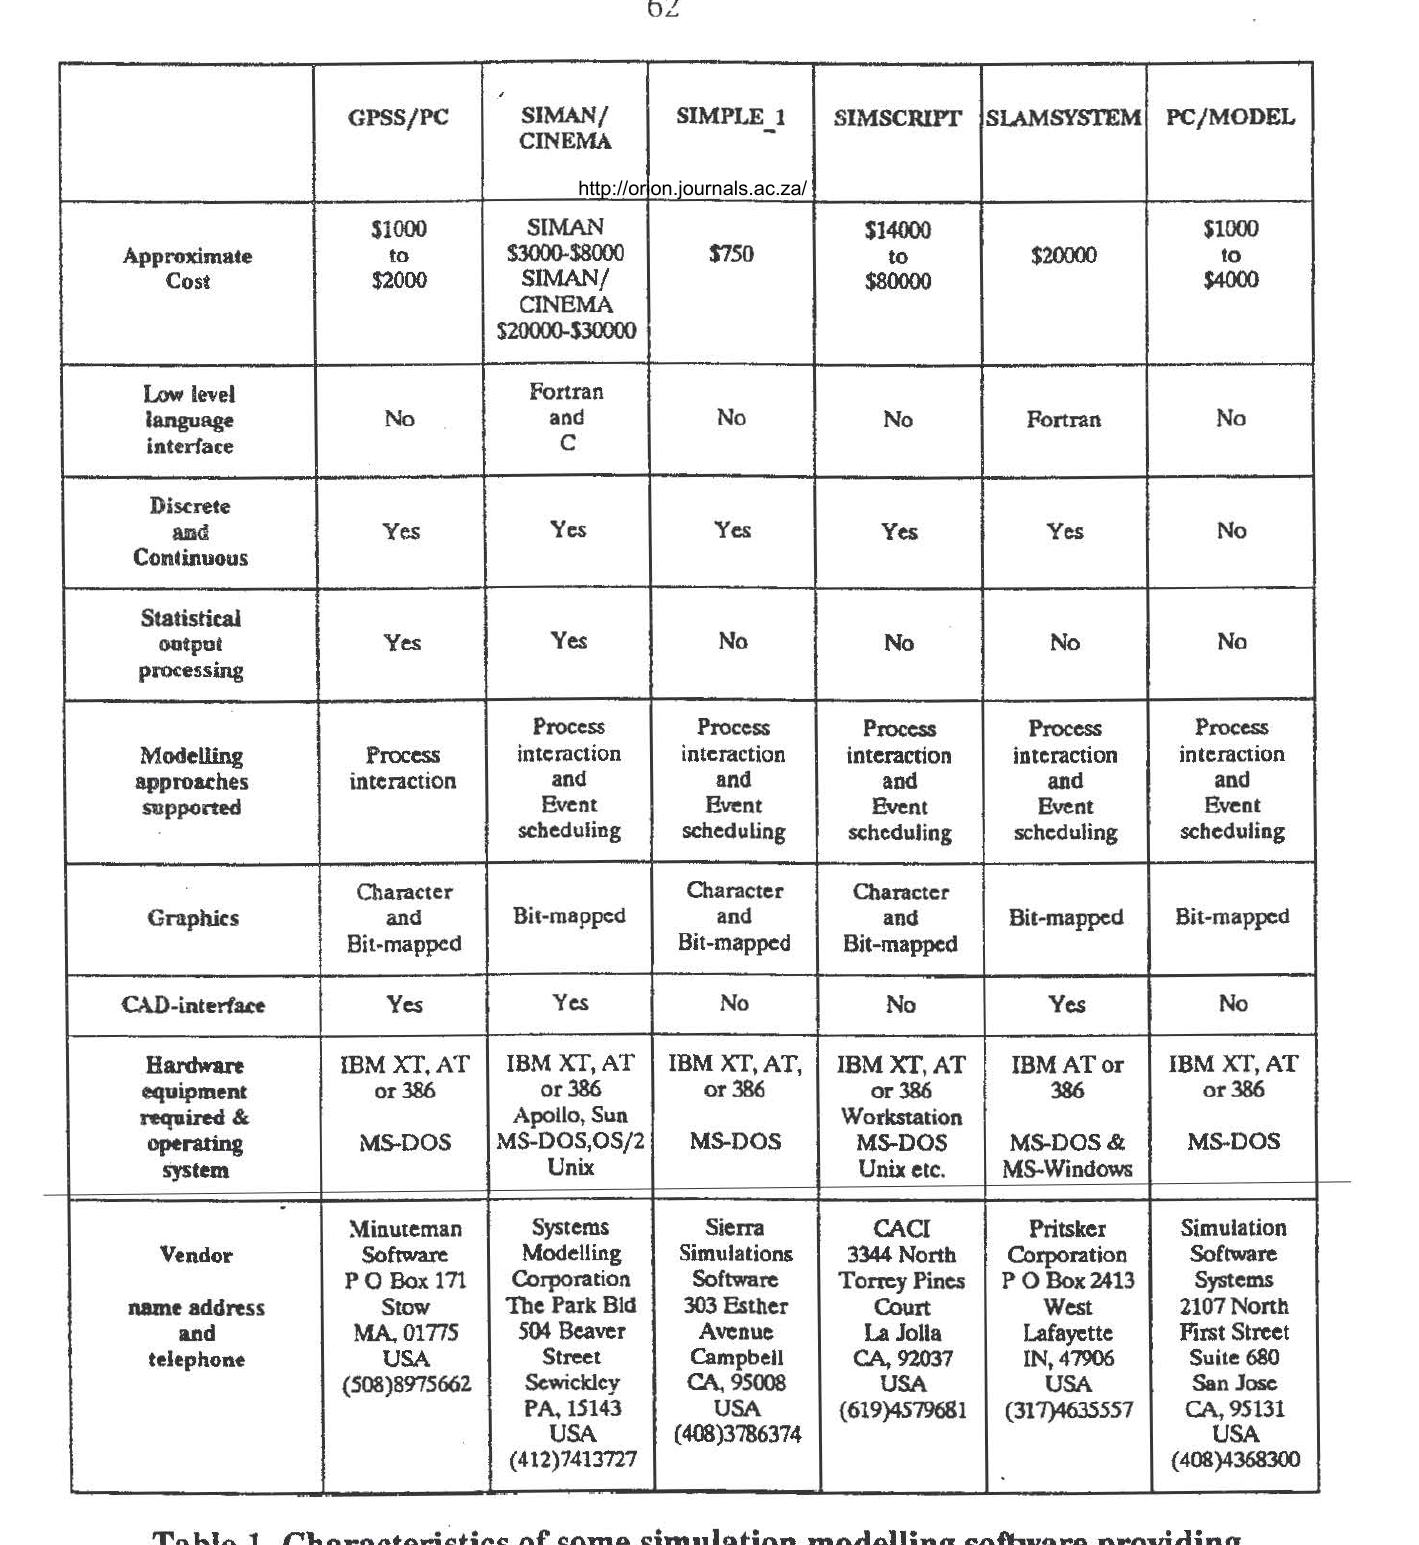
Table 1 Characteristics of some simulation modelling software providing animation